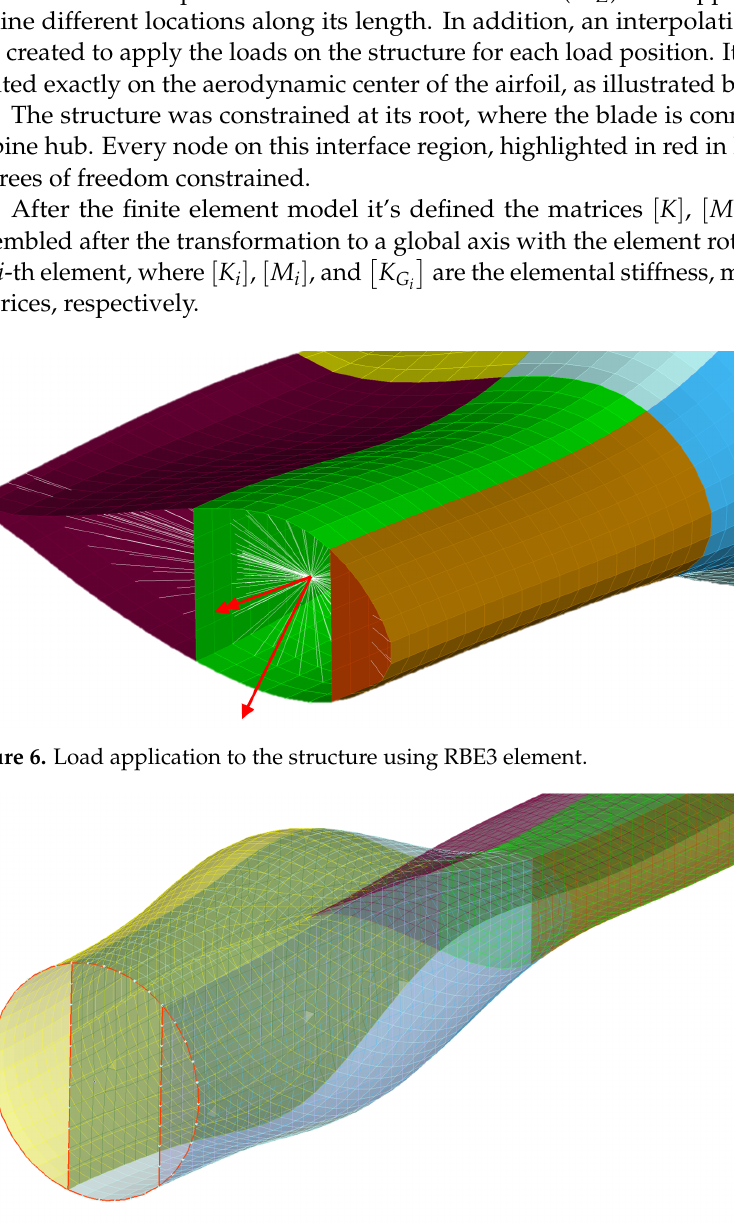
Figure 7. Fixed constraint applied to the root of the